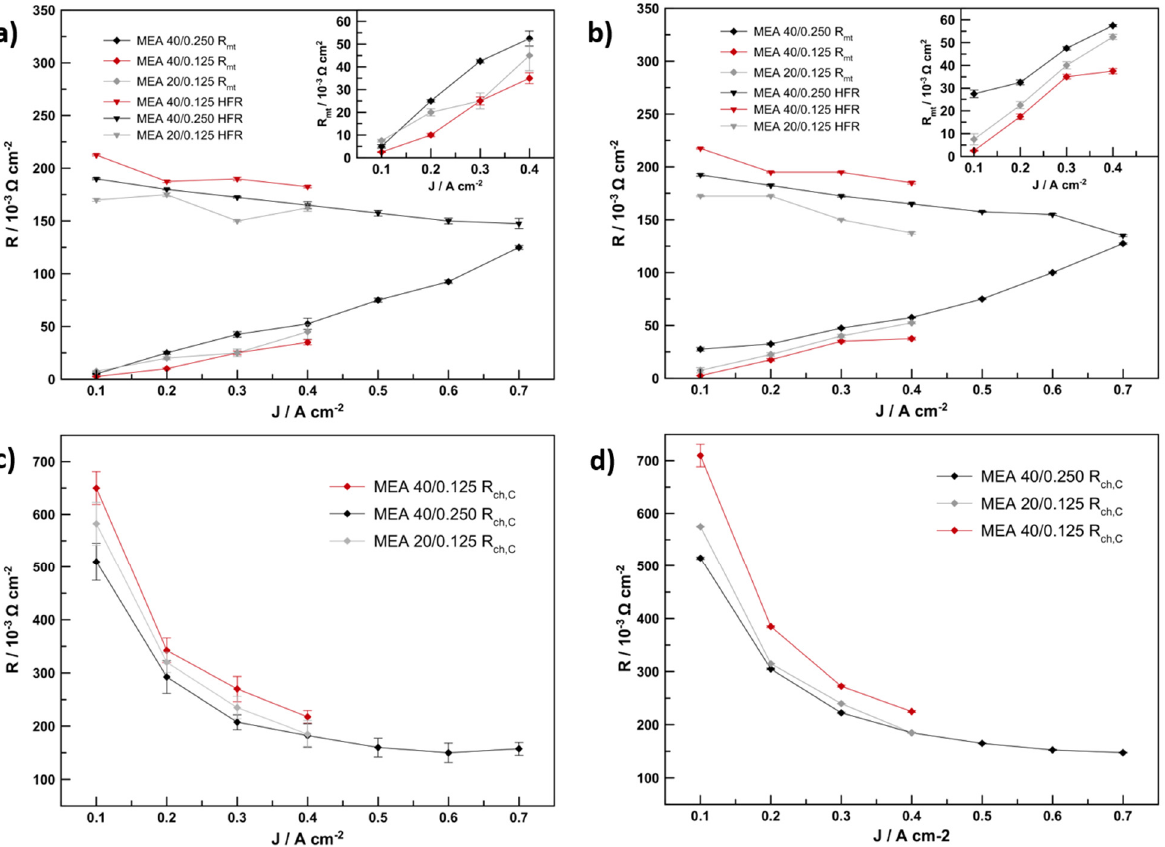
Figure 7. Trend of diffusion resistance R mt and cathode charge transfer resistance R ct,c with increasing catalyst layer thickness and current density obtained with ( a , c ) Model 1 and ( b , d ) Model 2. High-frequency resistance of all MEAs is shown for relation. Error bars represent the values at which the deviation of the model from the measured data starts to increase by more than 1% of the value.